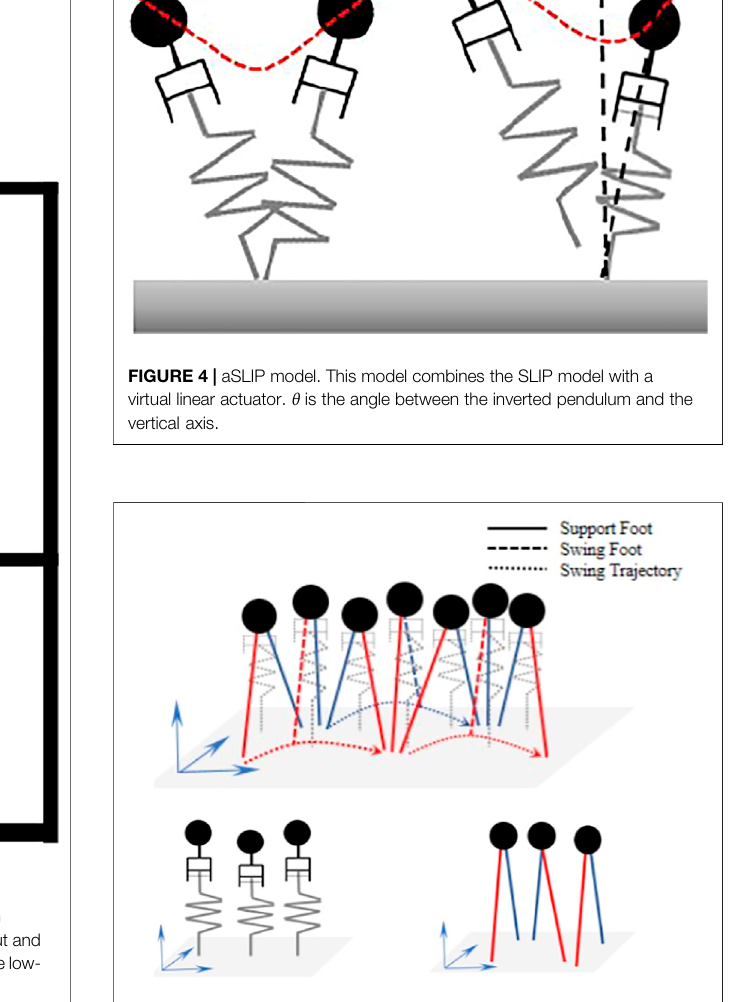
FIGURE 5 | Decoupled aSLIP model during walking (top), with vertical dynamics (bottom left), and horizontal dynamics (bottom right).